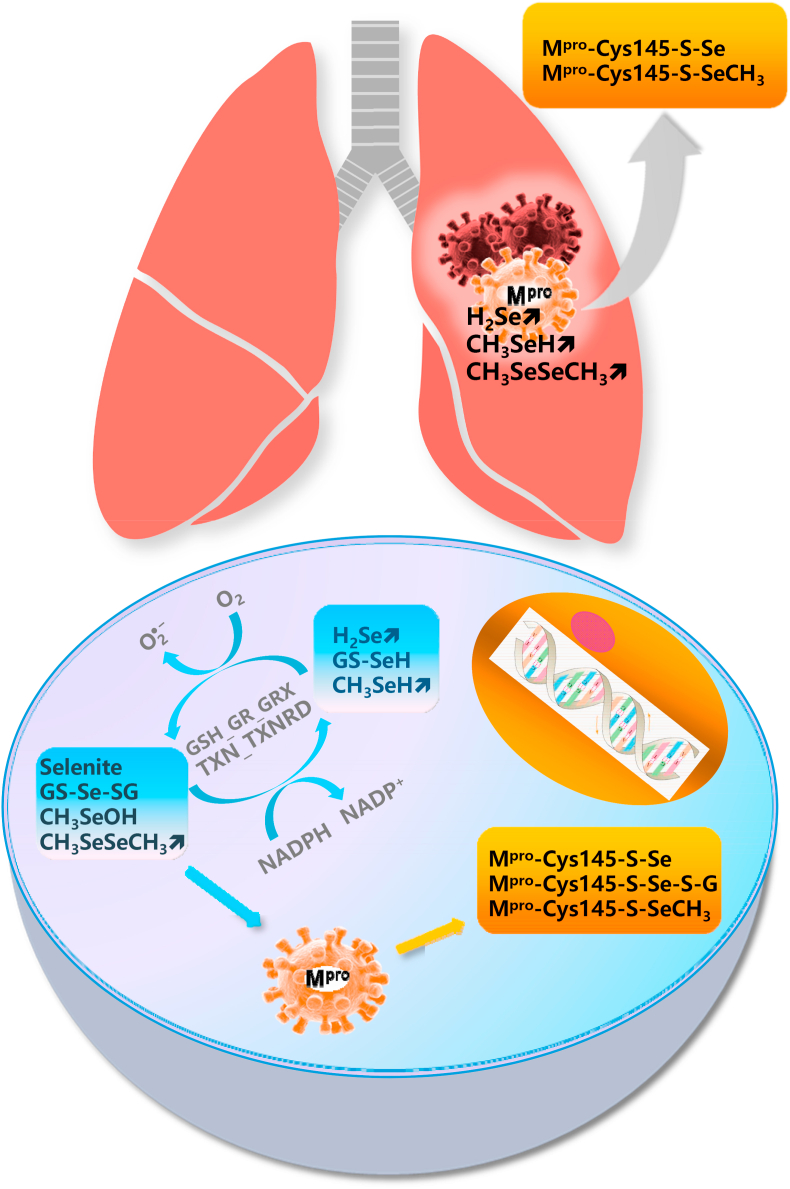
Hypothesised interaction of selenium compounds with SARS-CoV-2 consisting of cycling of redox-active selenium compounds in various cells (lower panel) and the presence of volatile redox-active selenium compounds in the lung (upper panel). GS-Se-SG, selenodiglutathione; CH3SeOH, methylseleninic acid; CH3SeSeCH3, dimethyldiselenide; H2Se, hydrogen selenide; GS-SeH, glutathione selenopersulfide; CH3SeH, methylselenol; GSH, glutathione; GR, GSH reductase; GRX, glutaredoxin; TXN, thioredoxin; TXNRD, TXN reductase.